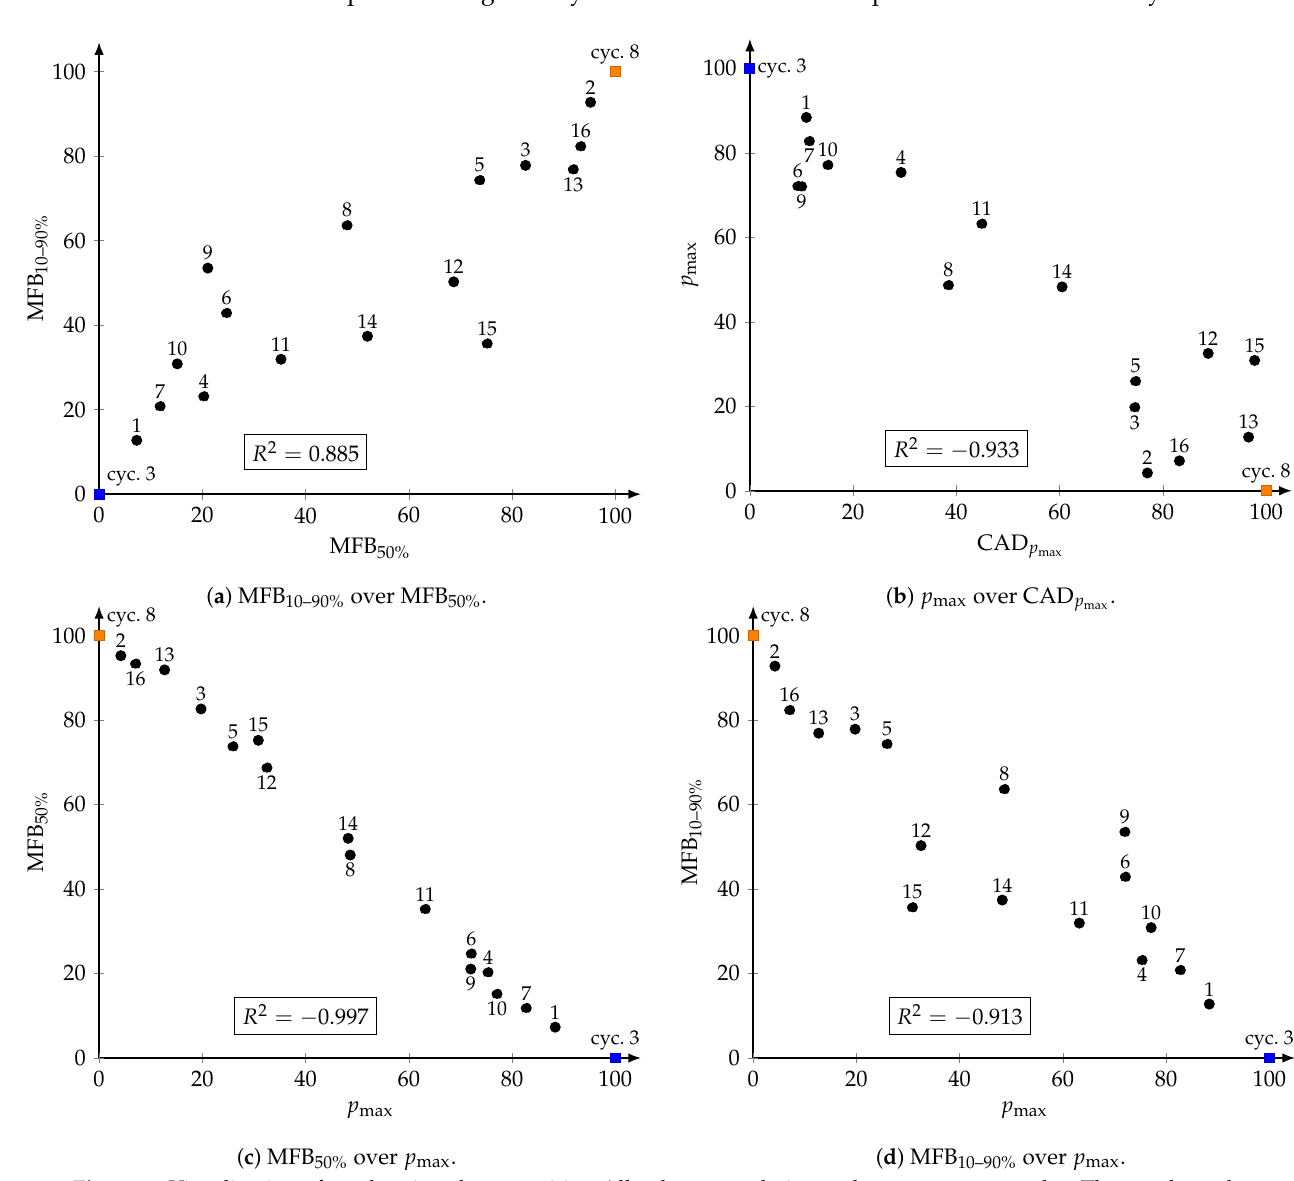
Figure 4. Visualization of combustion charactersitics. All values are relative to the two extreme cycles. The numbers above or below the markers correspond to the combination